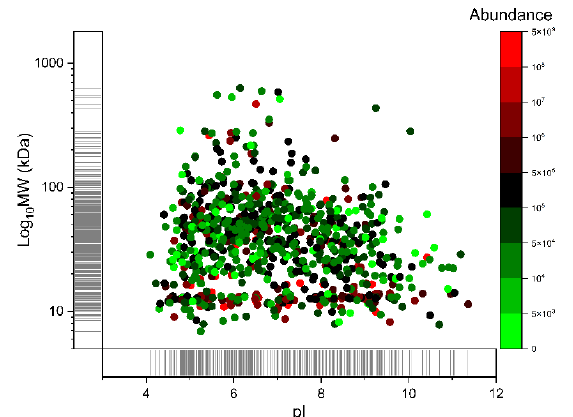
Figure 4. Virtual 2D map (theoretical MW vs. pI) of the identified proteins. The mean abundance of each protein is represented by the color scale reported on the right side, calculated as the average from its 3 most intense peptides, over 70 runs.